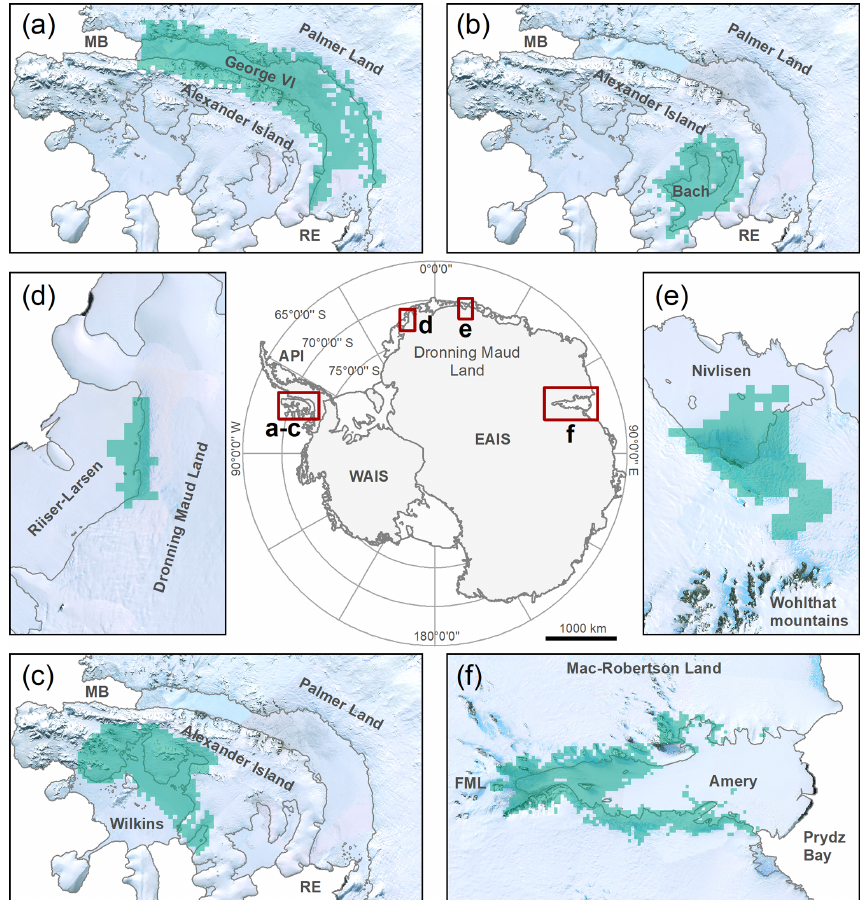
Figure 1. Overview map of Antarctica with the study regions on the Antarctic Peninsula (API) (a–c) and the East Antarctic Ice Sheet (EAIS) (d–f) outlined in red. The shaded turquoise area in (a) – (f) delineates the areas of interest used for statistical correlation analysis. Over Amery Ice Shelf, Beaver Lake, a permanent lake feature at the western grounding line, was excluded from analyses in order to avoid misclassifications in optical imagery. The outline of the Antarctic ice sheets is taken from IMBIE (2016), and coastline and grounding line data are from Mouginot et al. (2017) and Rignot et al. (2013). The background in (a) – (f) is the Landsat Image Mosaic of Antarctica (LIMA) (Bindschadler et al., 2008). MB: Marguerite Bay. RE: Ronne Entrance. FML: Fisher, Mellor and Lambert glacier systems. WAIS: West Antarctic Ice